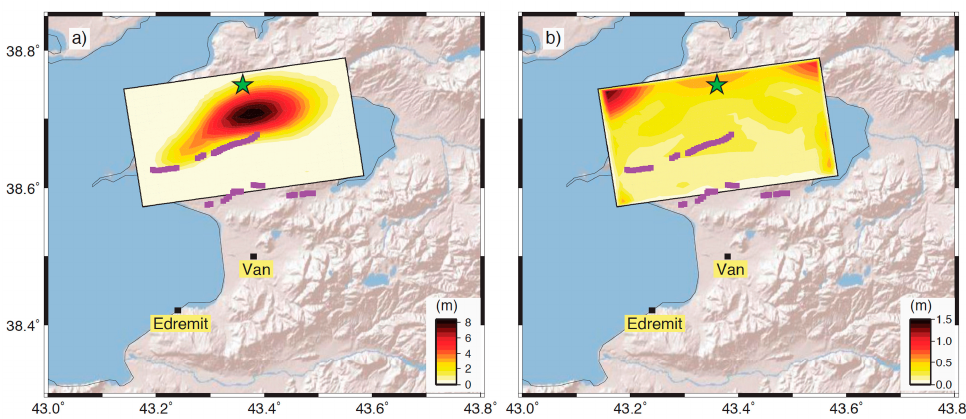
Figure 6. Fault slip distribution retrieved from geodetic data: ( a ) fault slip distribution; and ( b ) error associated. The surface fractures are reported by purple lines, and the Van earthquake epicenter by the green star.